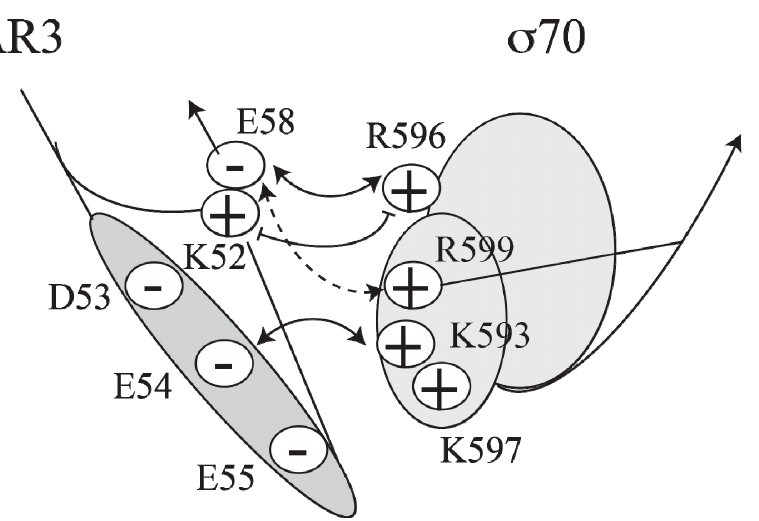
Figure 4. Model of the interactions between AR3 and sigma 70 (adapted from